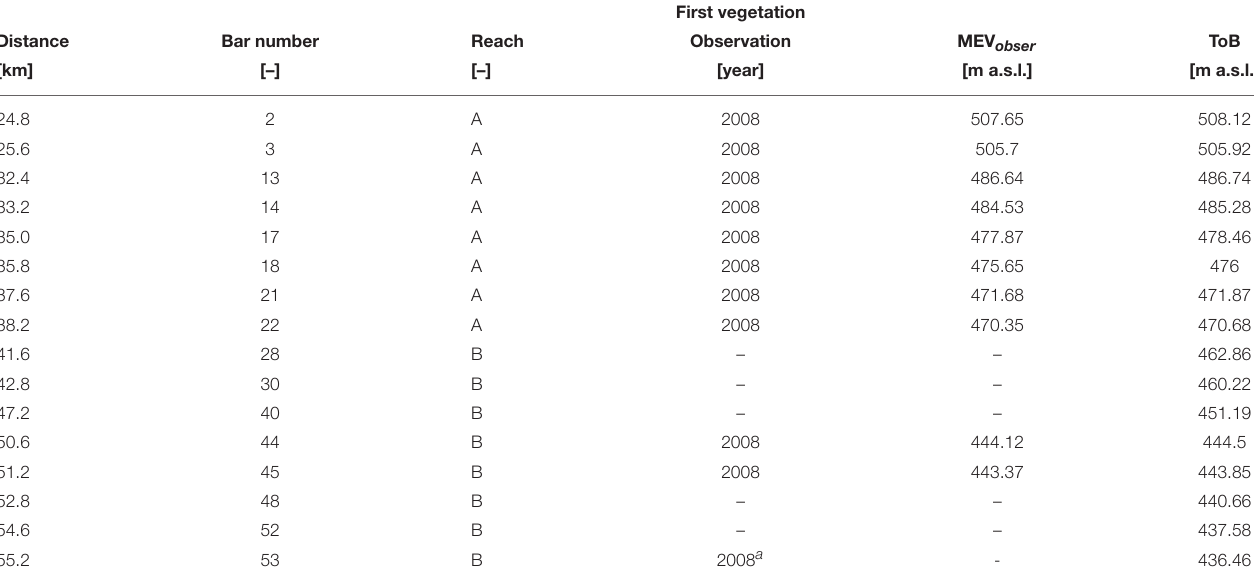
TABLE 2 | Target bars used for model calibration and